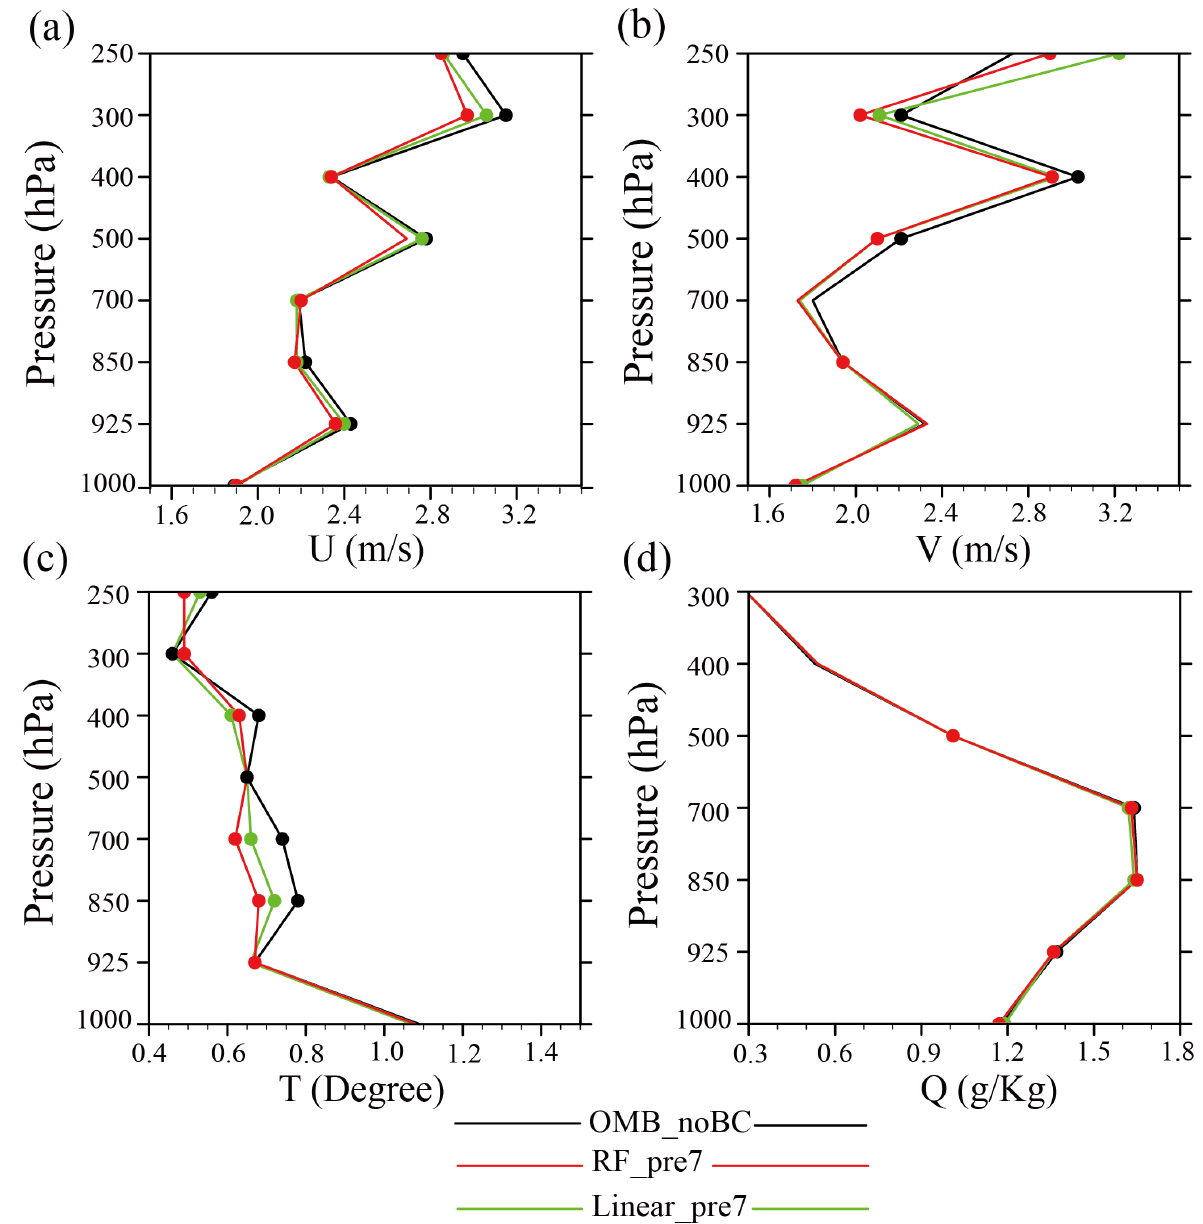
Figure 11. The root-mean-square error (RMSE) vertical profiles of the analyses with the radiances of AGRI channels 9–10 from the OMB_noBC (black lines), RF_pre7 (red lines), and Linear_pre7 (green lines) experiments, respectively, verified against the sounding and surface synoptic observations for ( a ) U-wind, ( b ) V-wind, ( c ) temperature, and ( d ) specific humidity valid at 0600 UTC 19 July 2021. The marked dots show a significance level above 95%.